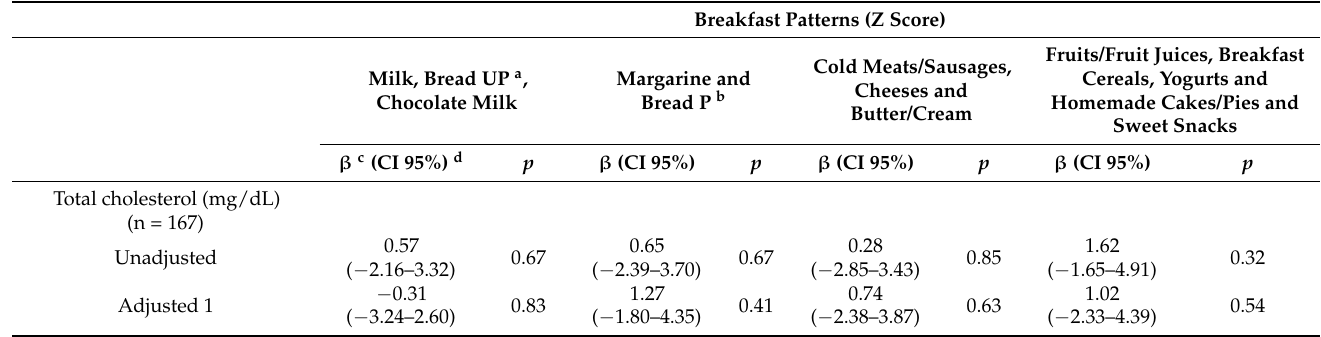
Table 6. Cross-sectional associations between cardiometabolic parameters and breakfast patterns of 169 children and adolescents with CHD. Brazil